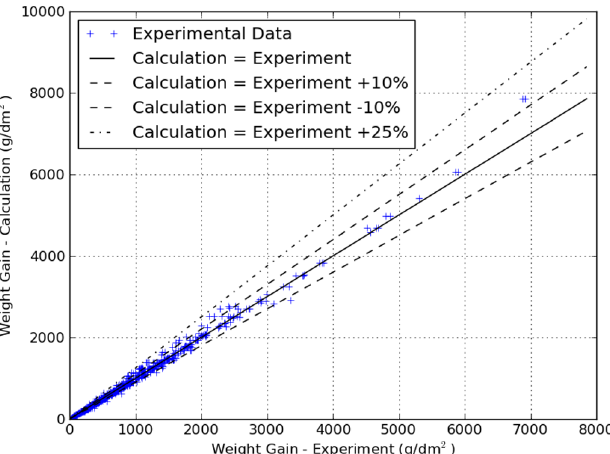
Fig. 4. Weight gain, comparison of experimental and UJP- correlation data.